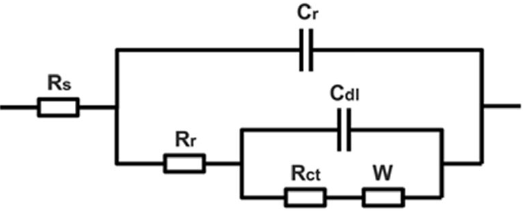
Figure 15. EIS plots of original and proanthocyanidins ‐ treated archaeological steel in area A and B. Nyquist plots ( a , b ); |Z| vs. frequency in Bode plots ( c , d ); θ vs. frequency in Bode plots ( e , f ).